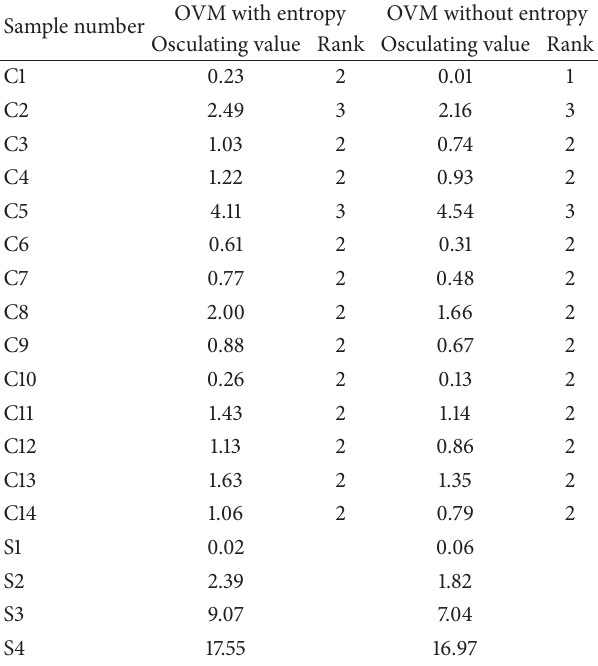
Table 3: Assessment results of osculating values method with entropy and without entropy for the confined water